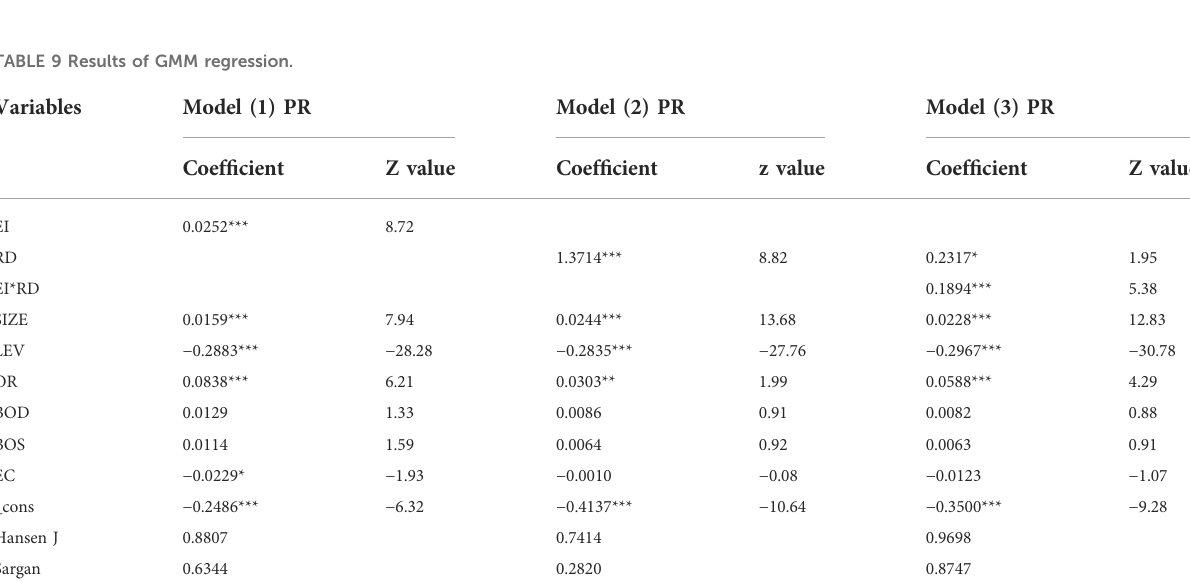
TABLE 9 Results of GMM regression.